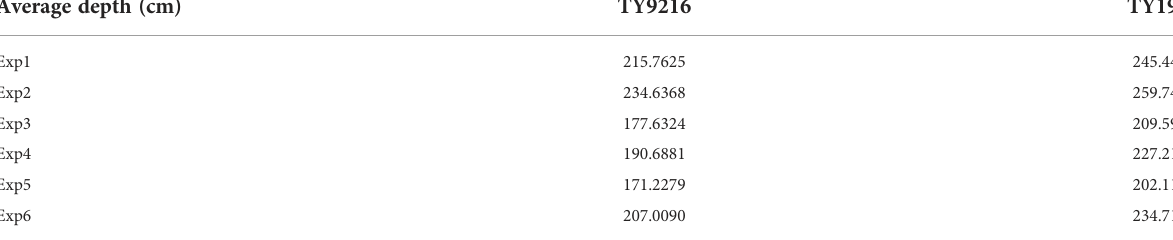
TABLE 5 The average inundation depth (unit: cm) along the LZB during TY9216 and TY1909. Average depth (cm)